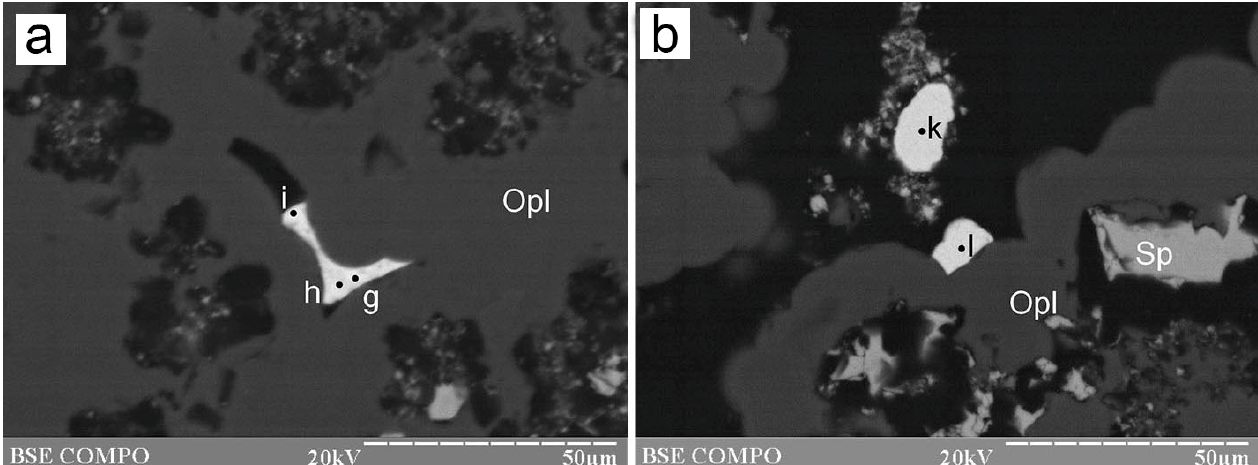
Figure 8. Morphology of As-bearing galena and Ag–Sb–Cu sulfosalts from the Irinovskoe HSF: ( a ) Interstitial aggregate of Pb–As–Cu-bearing Ag–Sb sulfosalts, the compositions of which can be recalculated to “pyrargyrite” (point i), “argentotetrahedrite-Zn” (point h) and “miargyrite” (point g); ( b ) Reniform aggregates of As-Cu-bearing Ag–Sb sulfosalt (“pyrargyrite”) (points k and l) on opal. BSE images. Sample 241. Table 5. Chemical composition of As-bearing galena from the Irinovskoe HSF, wt%. Analysis no. Figure Formula Based on 1 S Atom No. Figure 8a